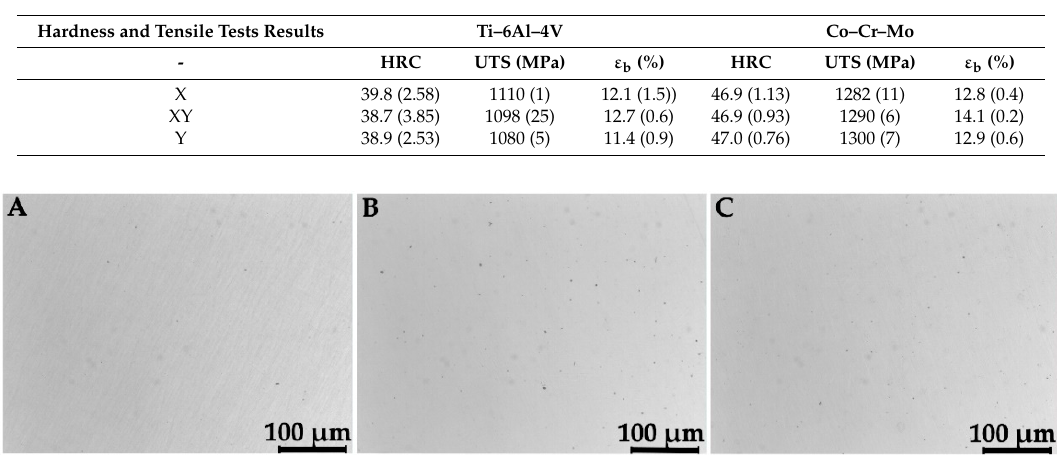
Figure 3. OM images of metallographic sections of Ti–6Al–4V specimens of the X ( A ), Y ( B ), and XY ( C ) groups.